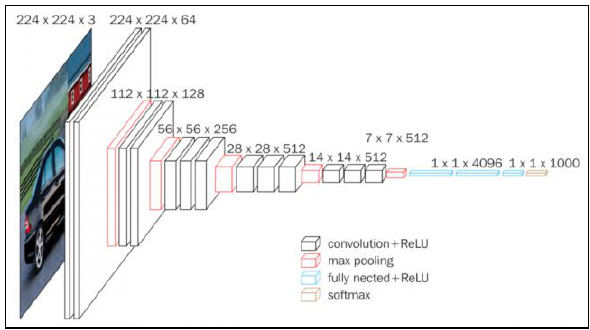
Figure 6. VGG16 Architecture (Simonyan and Zisserman 2015) The VGG16 network architecture (Simonyan and Zisserman 2015) is shown in figure 6.